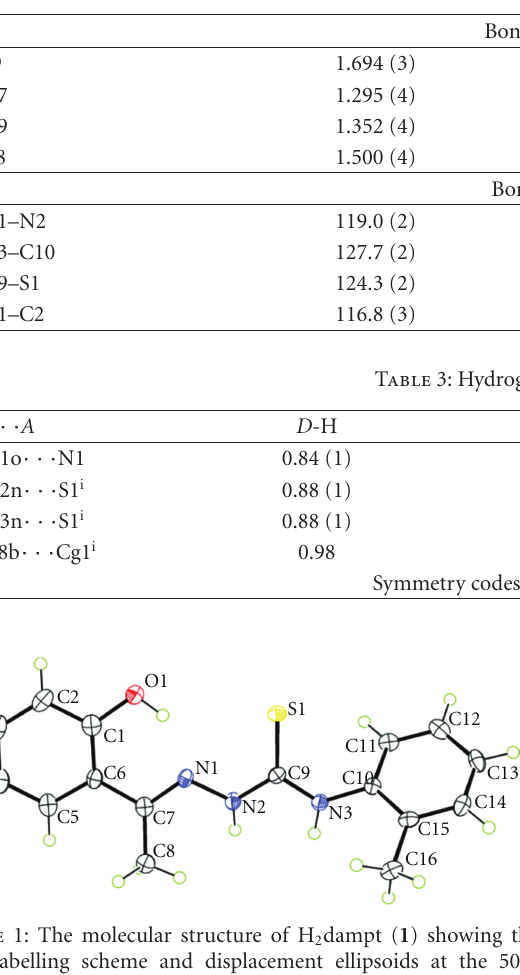
Table 2: Selected bond lengths (˚A) and bond angles ( ◦ ) of ligand [H 2 dampt] ( 1 ).